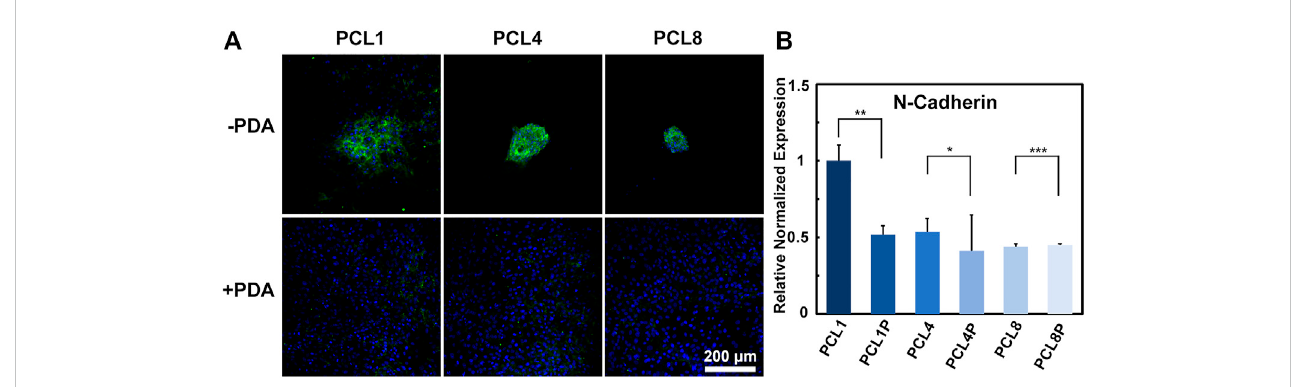
FIGURE 5 Cell-cell interaction of BMMSCs cultured on different substrates for 14 days. (A) Immuno fl uorescence staining for N-Cadherin protein (green: N-Cadherin; blue: Nuclear) ( n = 3) and (B) gene expressions of N-Cadherin of the cultured cells ( n =